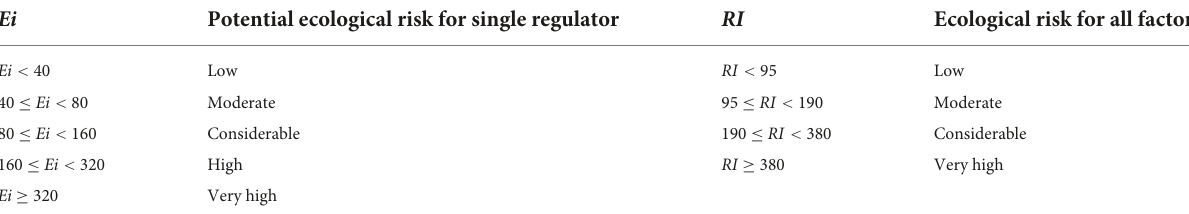
TABLE 2 Classification of potential ecological risks according to Ei and RI values (Hakanson, 1980; Yi et al., 2011; Liu et al., 2021). Ei Potential ecological risk for single regulator RI Ecological risk for all factors Ei < 40 Low RI < 95 Low 40 ≤ Ei < 80 Moderate 95 ≤ RI < 190 Moderate 80 ≤ Ei < 160 Considerable 190 ≤ RI < 380 Considerable 160 ≤ Ei < 320 High RI ≥ 380 Very high Ei ≥